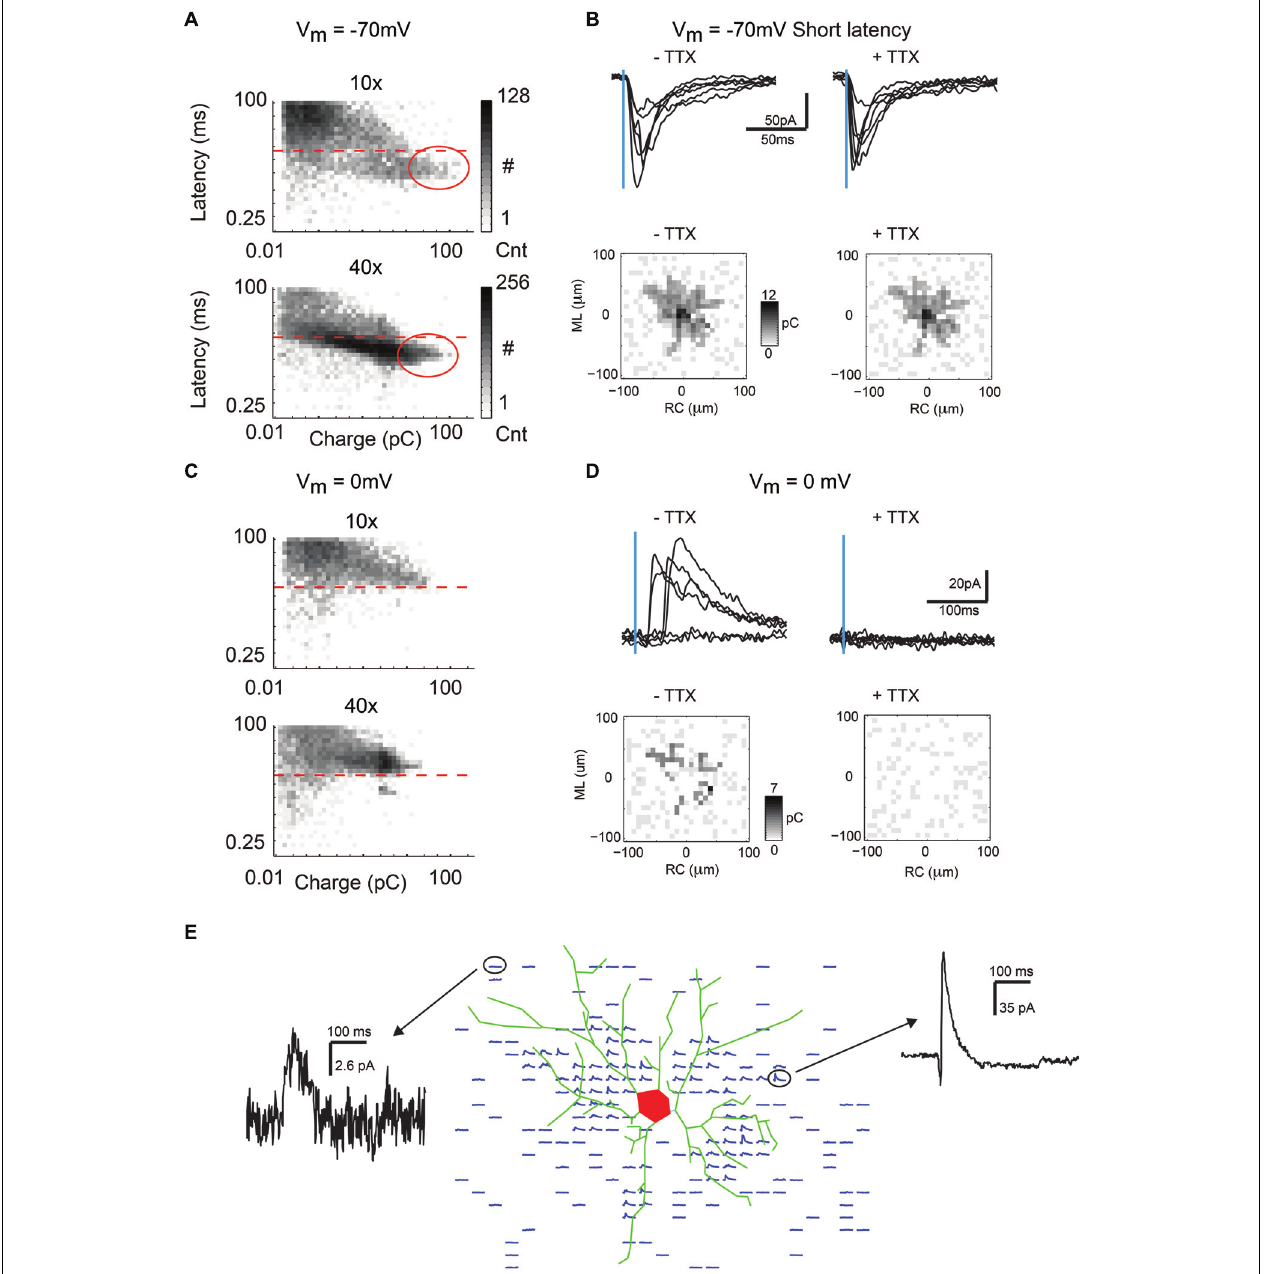
FIGURE 2 | Bath application ofTTX extinguishes IPSC but not direct currents recorded near the soma. (A) Two dimensional histogram (log scale event counts) of latency vs. charge for all inward currents recorded in response to photostimulation in our dataset ( N = 16250 events for 10 × , N = 20625 events for 40 × ). Dashed line indicates the 8 ms cutoff used to distinguish direct from synaptic events. Notice the cutoff mostly separates out the largest and fastest events that are direct currents.The approximate area of the largest direct currents is circled. (B) Direct currents are large-amplitude and short-latency inward currents that result from direct excitation of the recorded neuron by glutamate photorelease near the soma or proximal dendrites (top left).These currents are resistant toTTX (top right). Maps (from single neurons shown in top panels) showing total charge of direct events created before and after bathTTX application are very similar